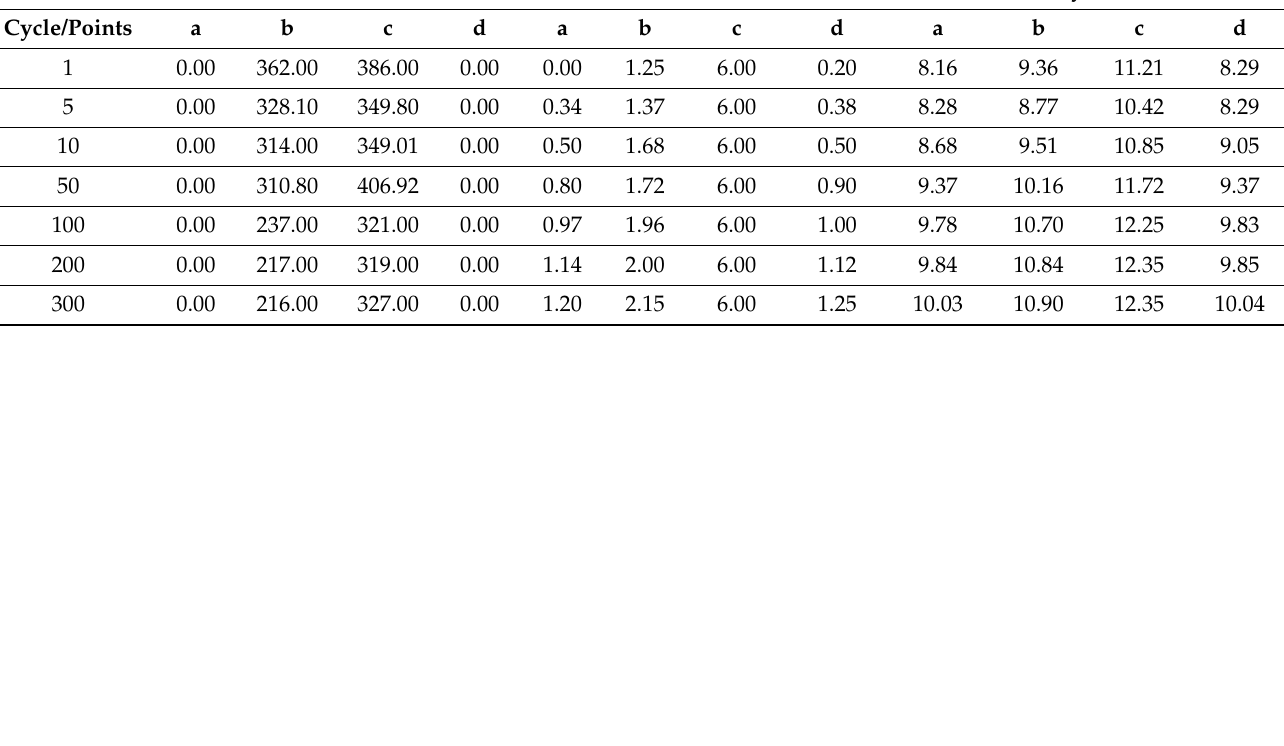
Table 1. Evolution of the stress, strain and resistivity values of the NiTi wire corresponding to points a, b, c and d. Stress (MPa) Strain